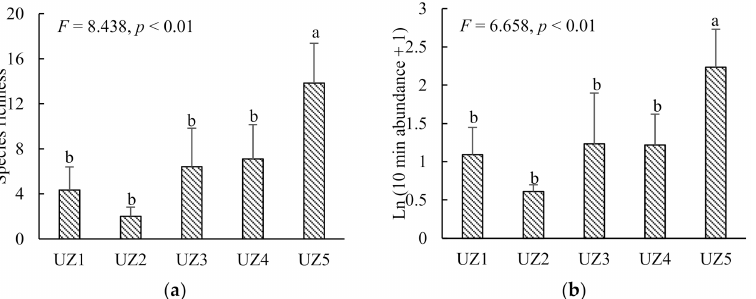
Figure 3. Differences of butterfly species richness ( a ) and abundance ( b ) (mean ± SE) among five urban zones (UZ1, urban core; UZ5, urban fringe). Different letters above the bars indicate significant differences at p <